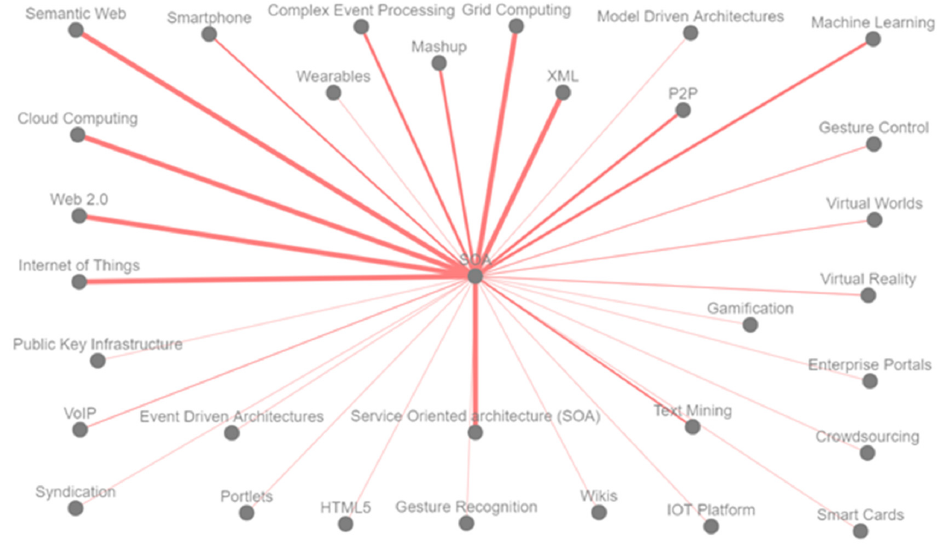
Figure 14. Graphical representation of relationships.